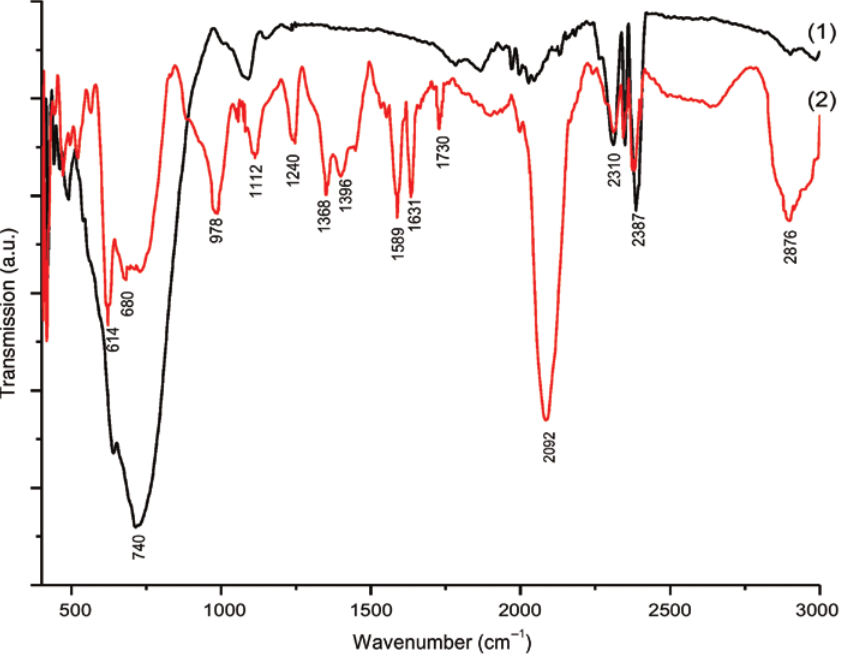
Figure 2: FTIR spectrum of an unetched a-SiC sample (curve 1) and FTIR spectrum of an a-SiC sample etched at the anodic current density of 0.5 mA/cm 2 in the 0.5% HF/EG solution for 30 min (curve